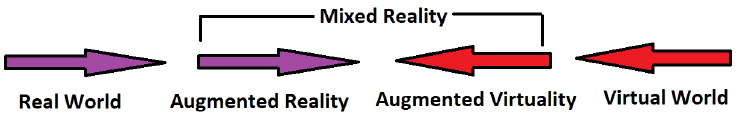
Figure 1. Reality-Virtuality